Question: Identify the chart type used in this figure.
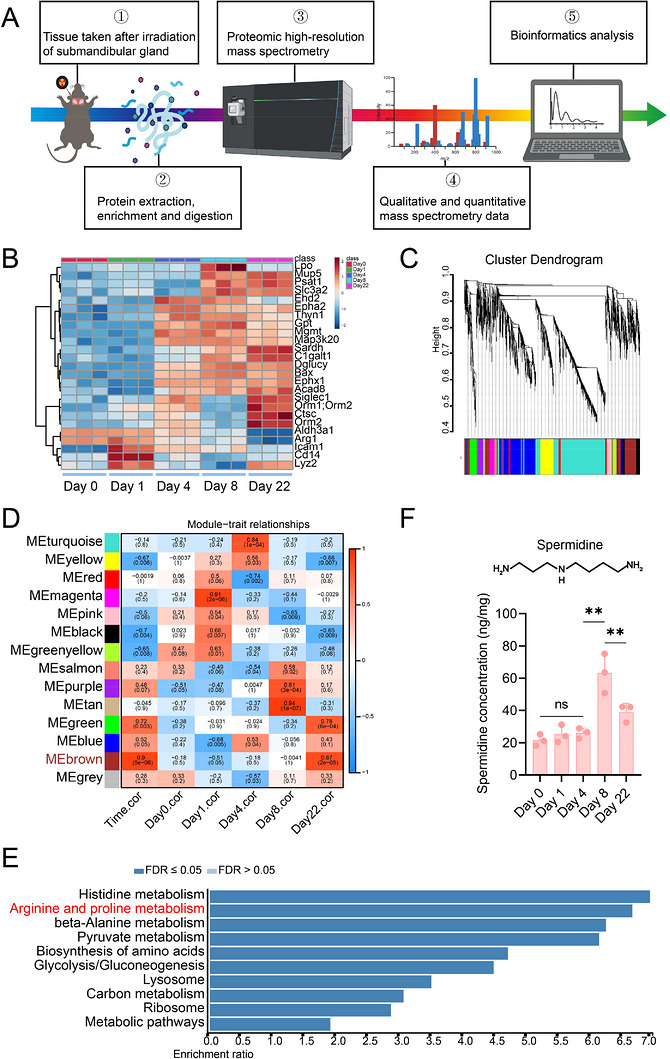
Answer: heatmap